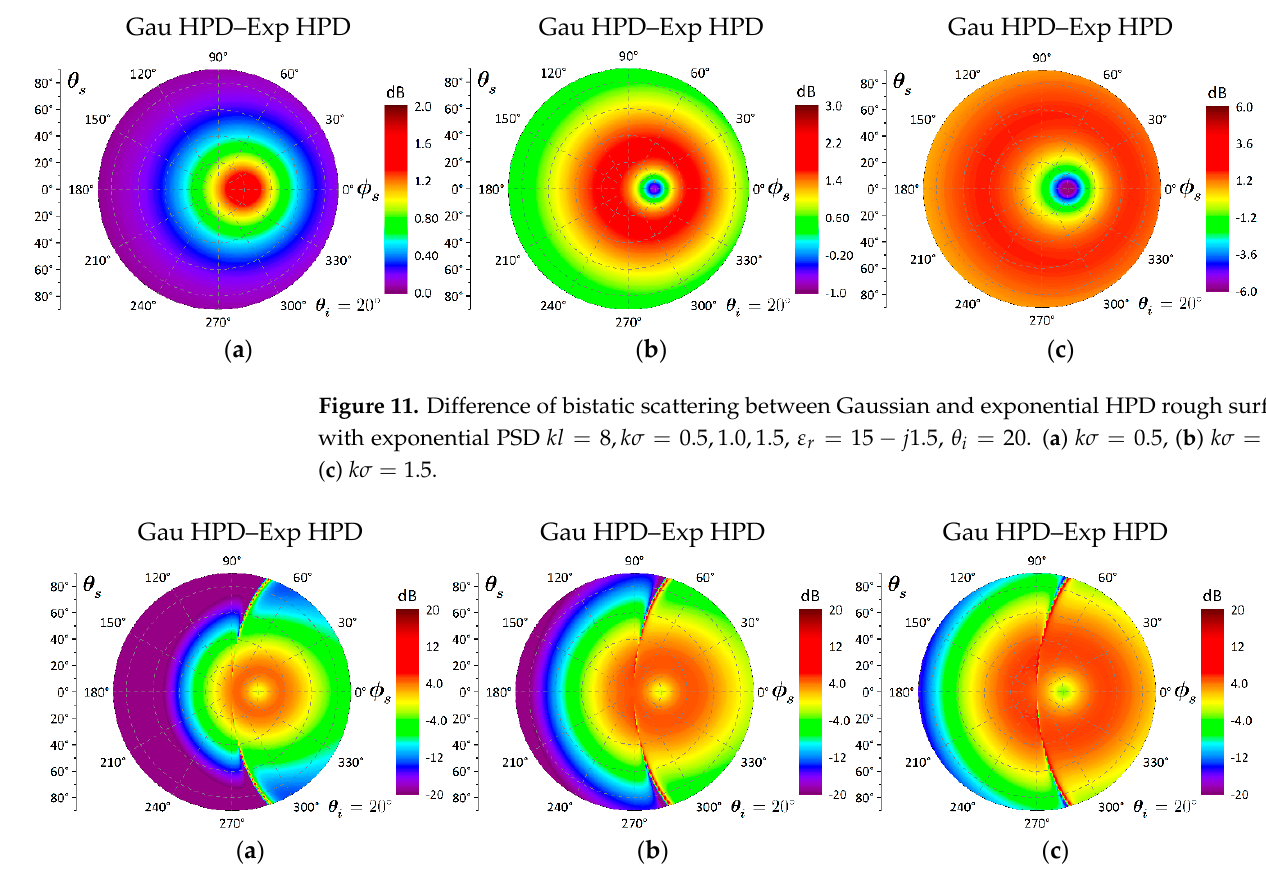
Figure 12. Difference of bistatic scattering between Gaussian HPD surface with Gaussian PSD and exponential HPD with exponential PSD . kl = 8, k σ = 0.5,1.0, 1.5, ε r = 15 − j 1.5, θ i = 20. ( a ) k σ = 0.5, ( b ) k σ = 1.0, ( c ) k σ =